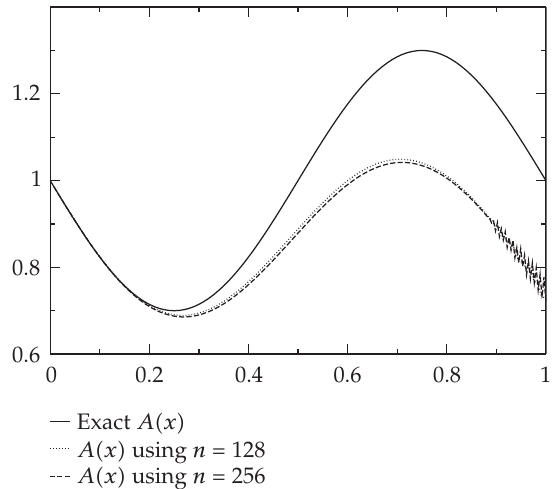
Figure 7.4 . Discretization has much less e ff ect than linearization on the reconstructions. Here, results using n = 128 and n = 256 grid points are nearly identical. In this case, A ( x ) = 1 − . 3sin ( 2 πx ) and b 1 = − .